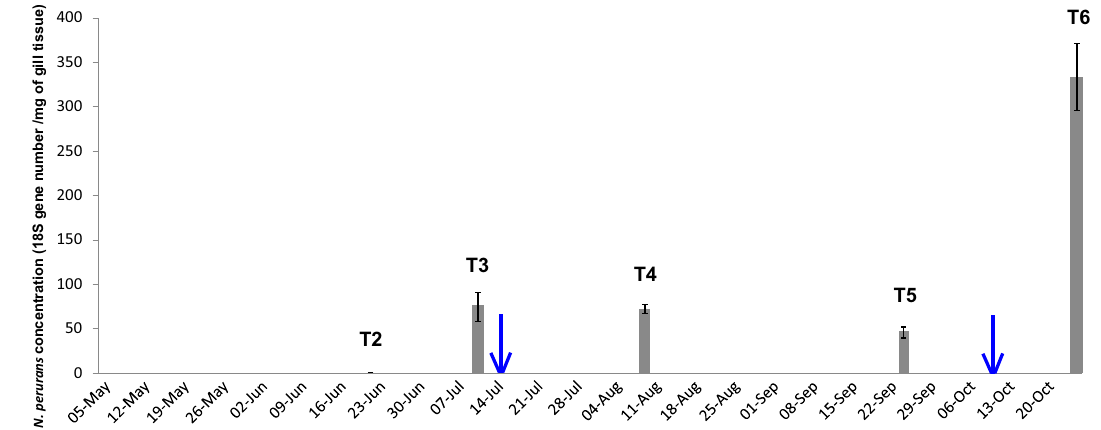
Figure 3. Concentrations of N. perurans 18S rRNA genes in DNA extractions from salmon gills measured by qPCR assays along the sampling campaign (from May until October 2017). Blue arrows mark the time when the fish farm treated salmon with freshwater